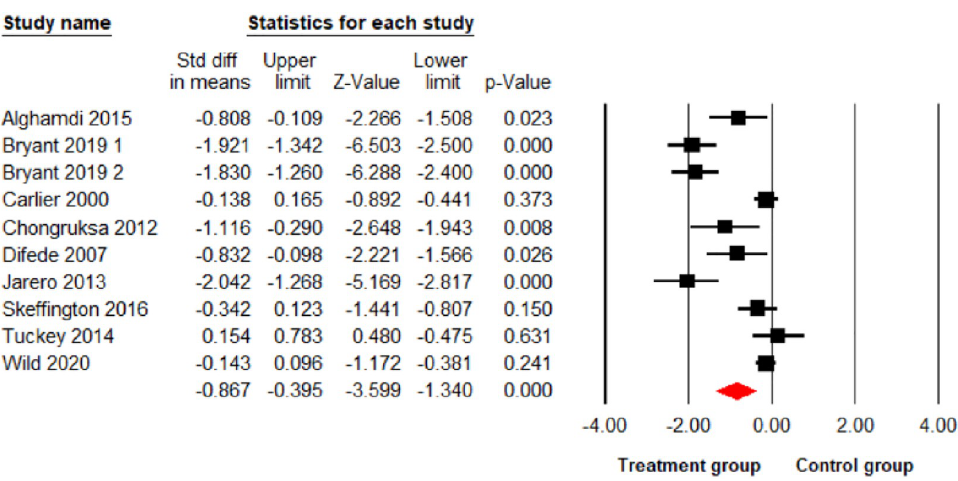
Fig 2. Forest plot for the effect of interventions on PTSD symptoms.